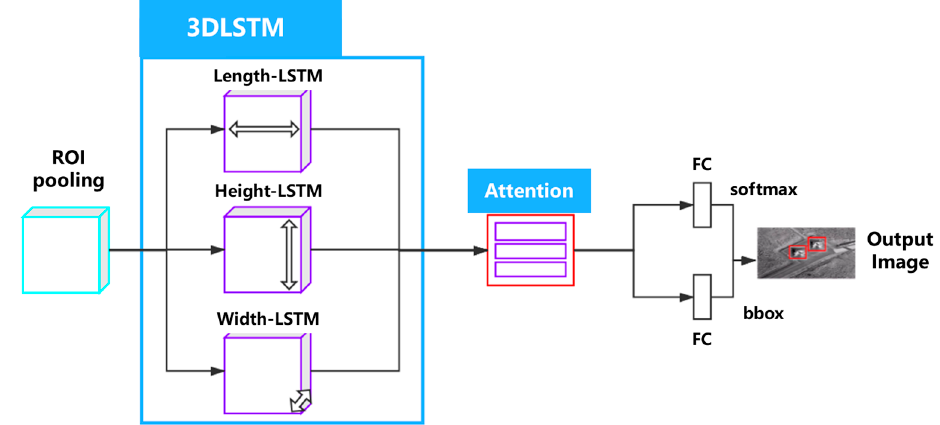
Figure 6. 3DLSTM network structure diagram.